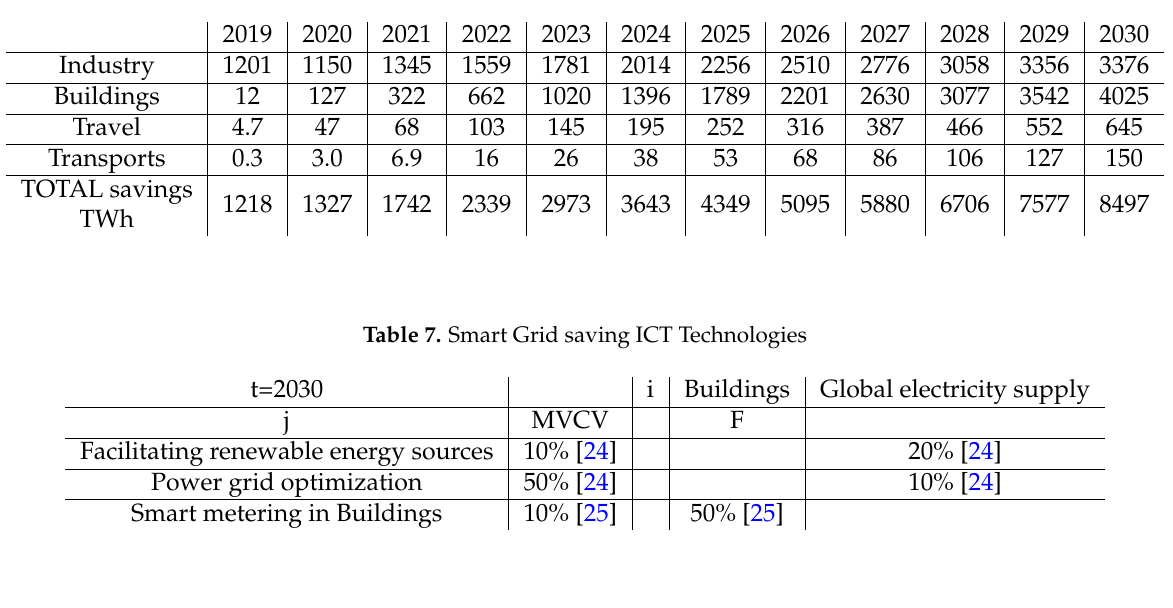
Table 6. Estimation of electricity handprint (TWh) enabled by ICT Solutions 2019-2030.